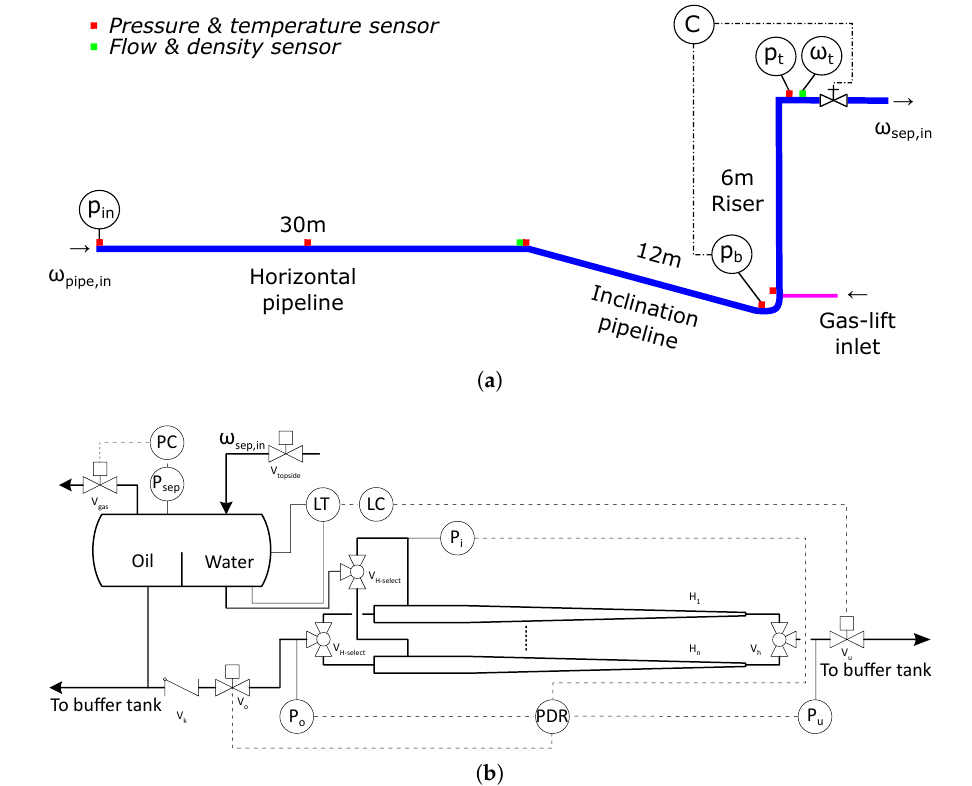
Figure 1. Two illustrations of the linked laboratory-scaled pipeline-riser and separator-hydrocyclone processes, including the respective control loops [31]. ( a ) The pipeline-riser section including the anti-slug controller actuates the topside choke valve with feedback data from P b . The riser outlet ( ω sep , in ) is the inlet to the gravity separator. Furthermore, several unused pressure, temperature, flow and density measurements are available for monitoring the system. ( b ) The 3-phase gravity separator and deoiling hydrocyclone. The water level and PDR control loops are illustrated. Only one hydrocyclone ( H 1 ) is applied in this paper. A more detailed separator and hydrocyclone laboratory description can be found in [29].